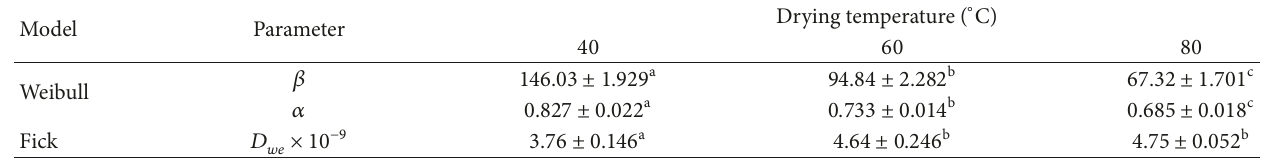
Table 1: Kinetic parameters of Weibull and Fick models for drying process.